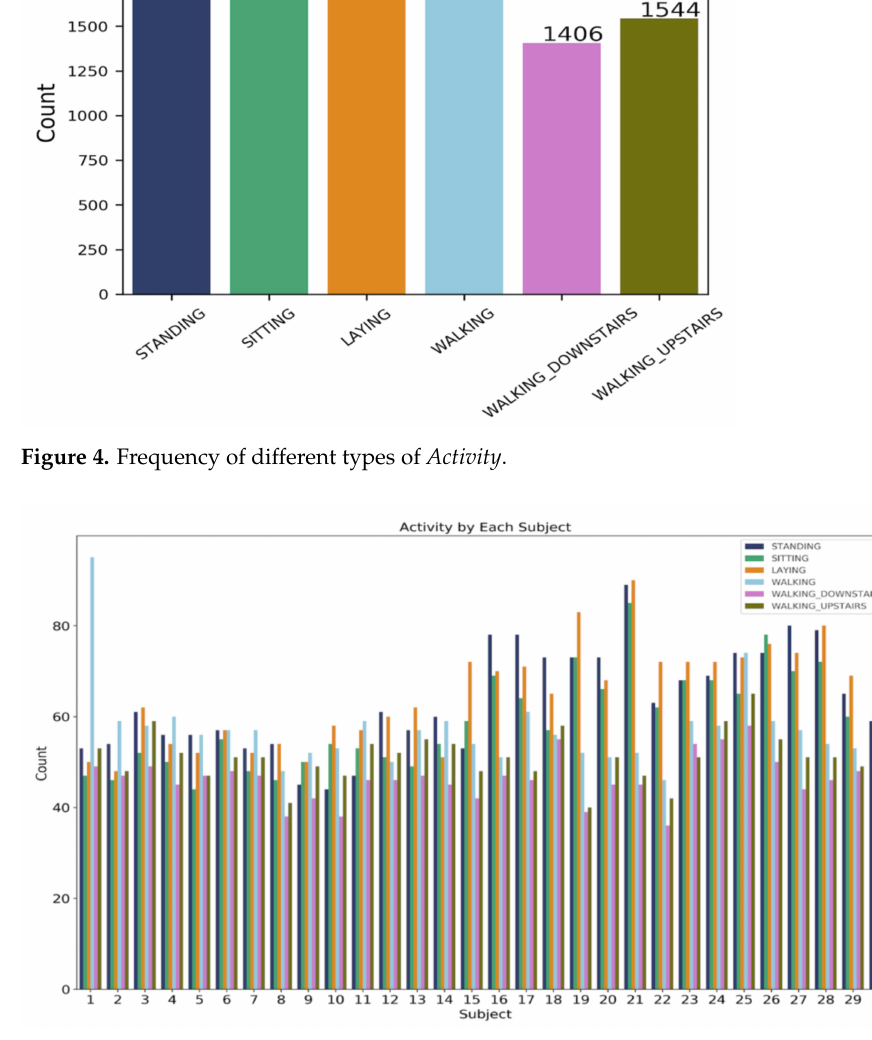
Figure 5. Total count for activity by different